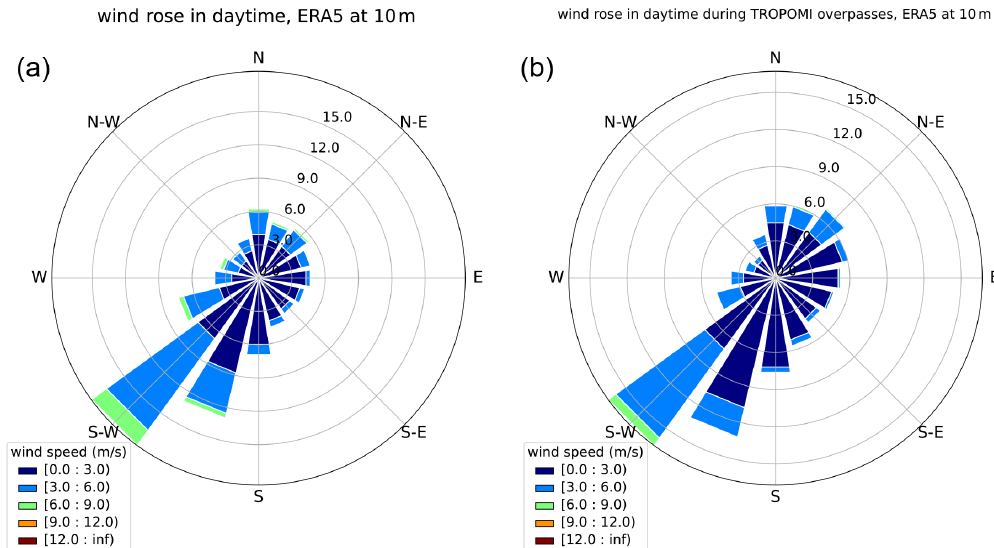
Figure 5. Wind roses for daytime (08:00–19:00UTC) from 10 November 2017 to 10 October 2020 for the ERA5 model wind. Panel (a) covers all days and panel (b) covers the days with TROPOMI overpasses. Table 3. Number of days and the averaged ERA5 wind speed ( ± standard deviation) per specific wind area in daytime (08:00–18:00UTC) from 10 November 2017 to 10 October 2020. Columns 2 and 3 are for all days, and columns 4 and 5 are for days with TROPOMI overpass. TROPOMI overpass Number of days Averaged wind speed